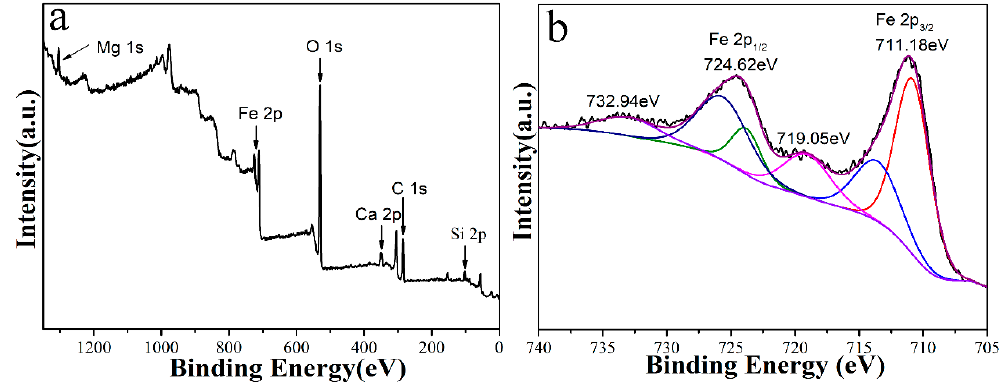
Figure 2. XPS spectra of M2: wide scan ( a ); high-resolution Fe 2p ( b ).